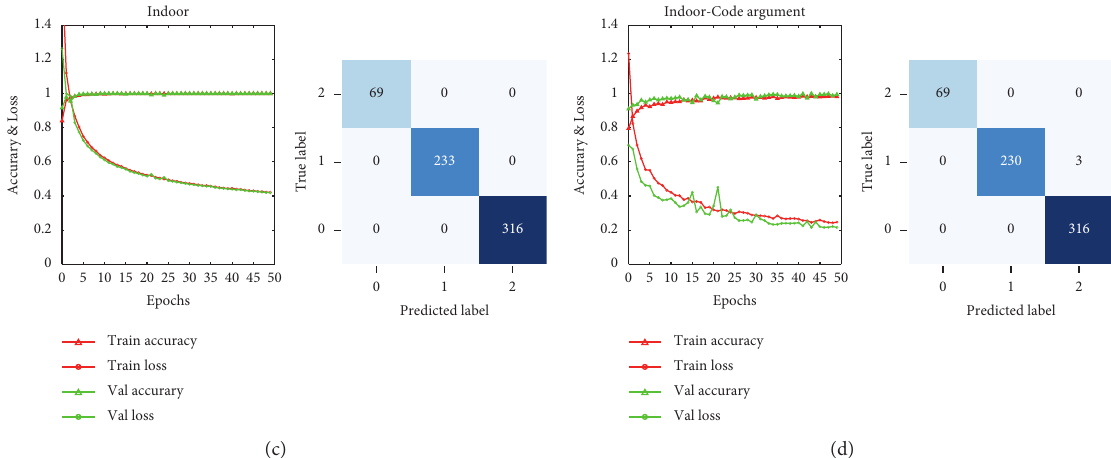
Figure 7: No image argumentation results for (a) outdoor without code, (b) outdoor with code, (c) indoor without code, and (d) indoor with code.